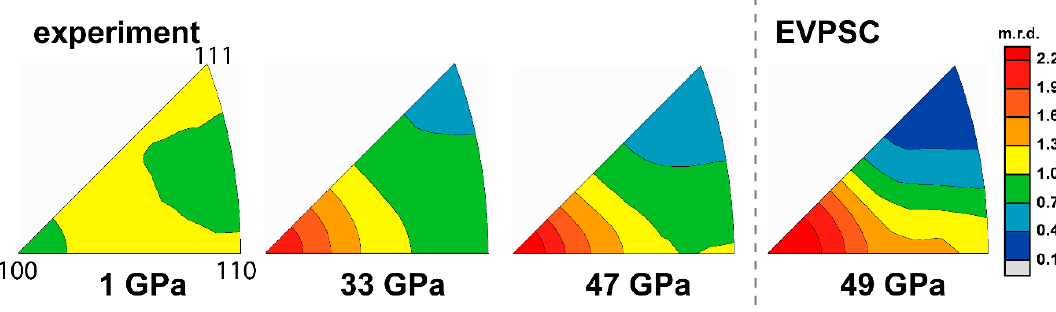
Figure 4. ( a ) Experiment and modeled Q-factors of pure MgO; ( b ) slip system activity; replotted from [48].